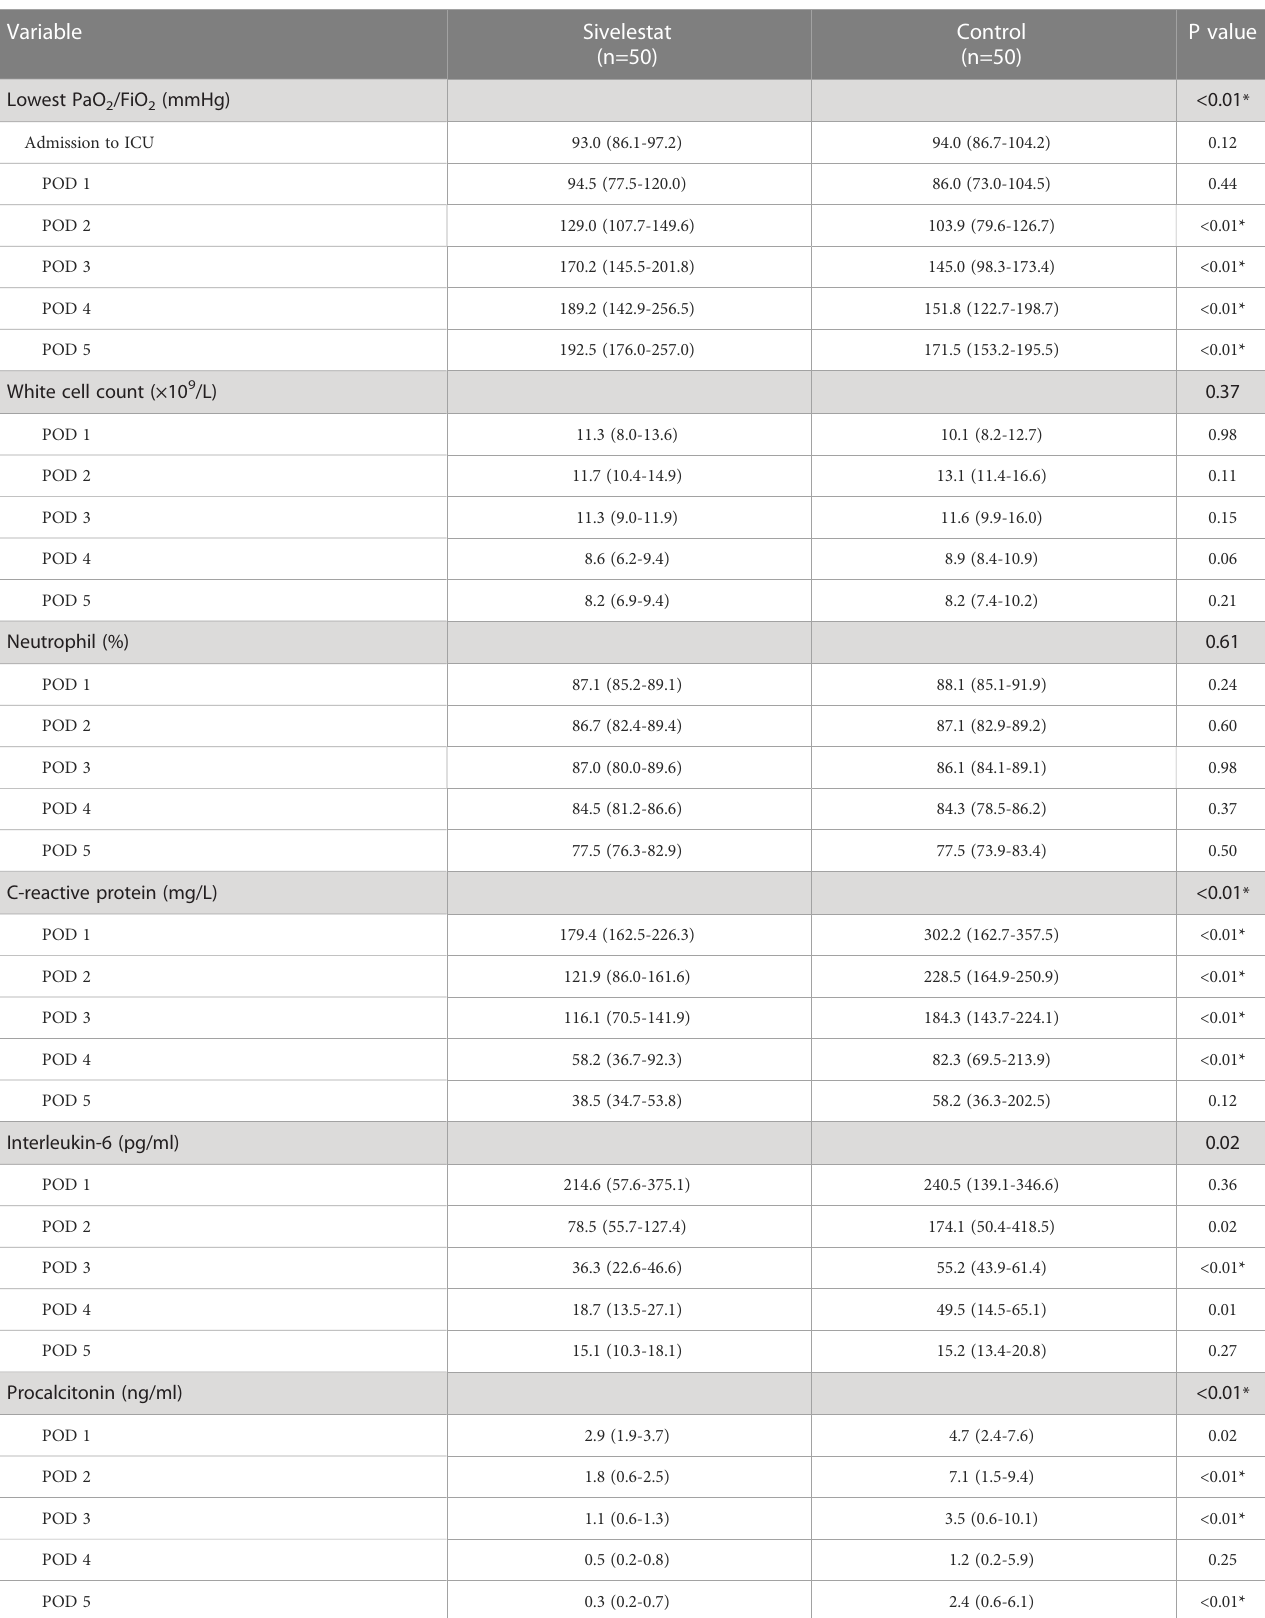
TABLE 4 PaO2/FiO2 and biomarkers of in fl ammation within postoperative 5 days.